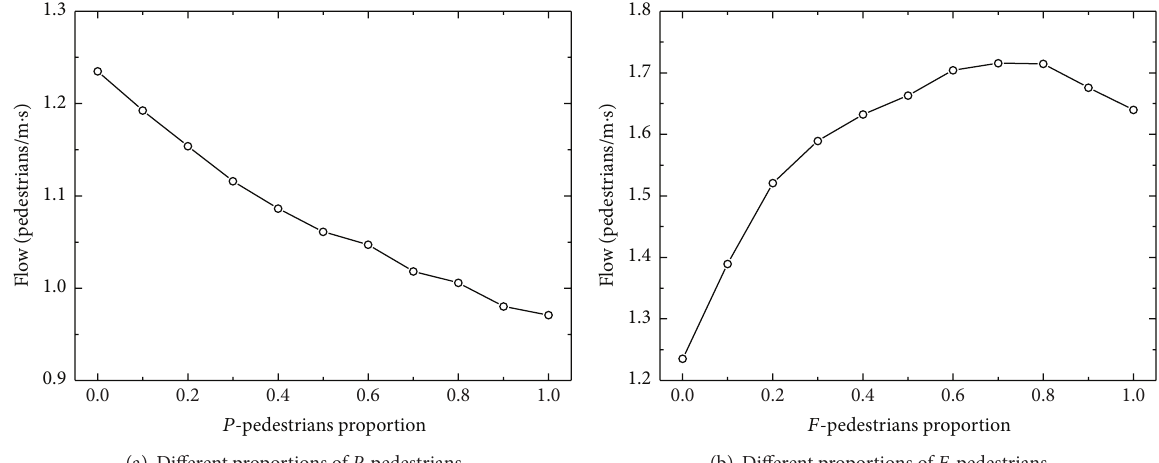
Figure 9: Capacity curves.